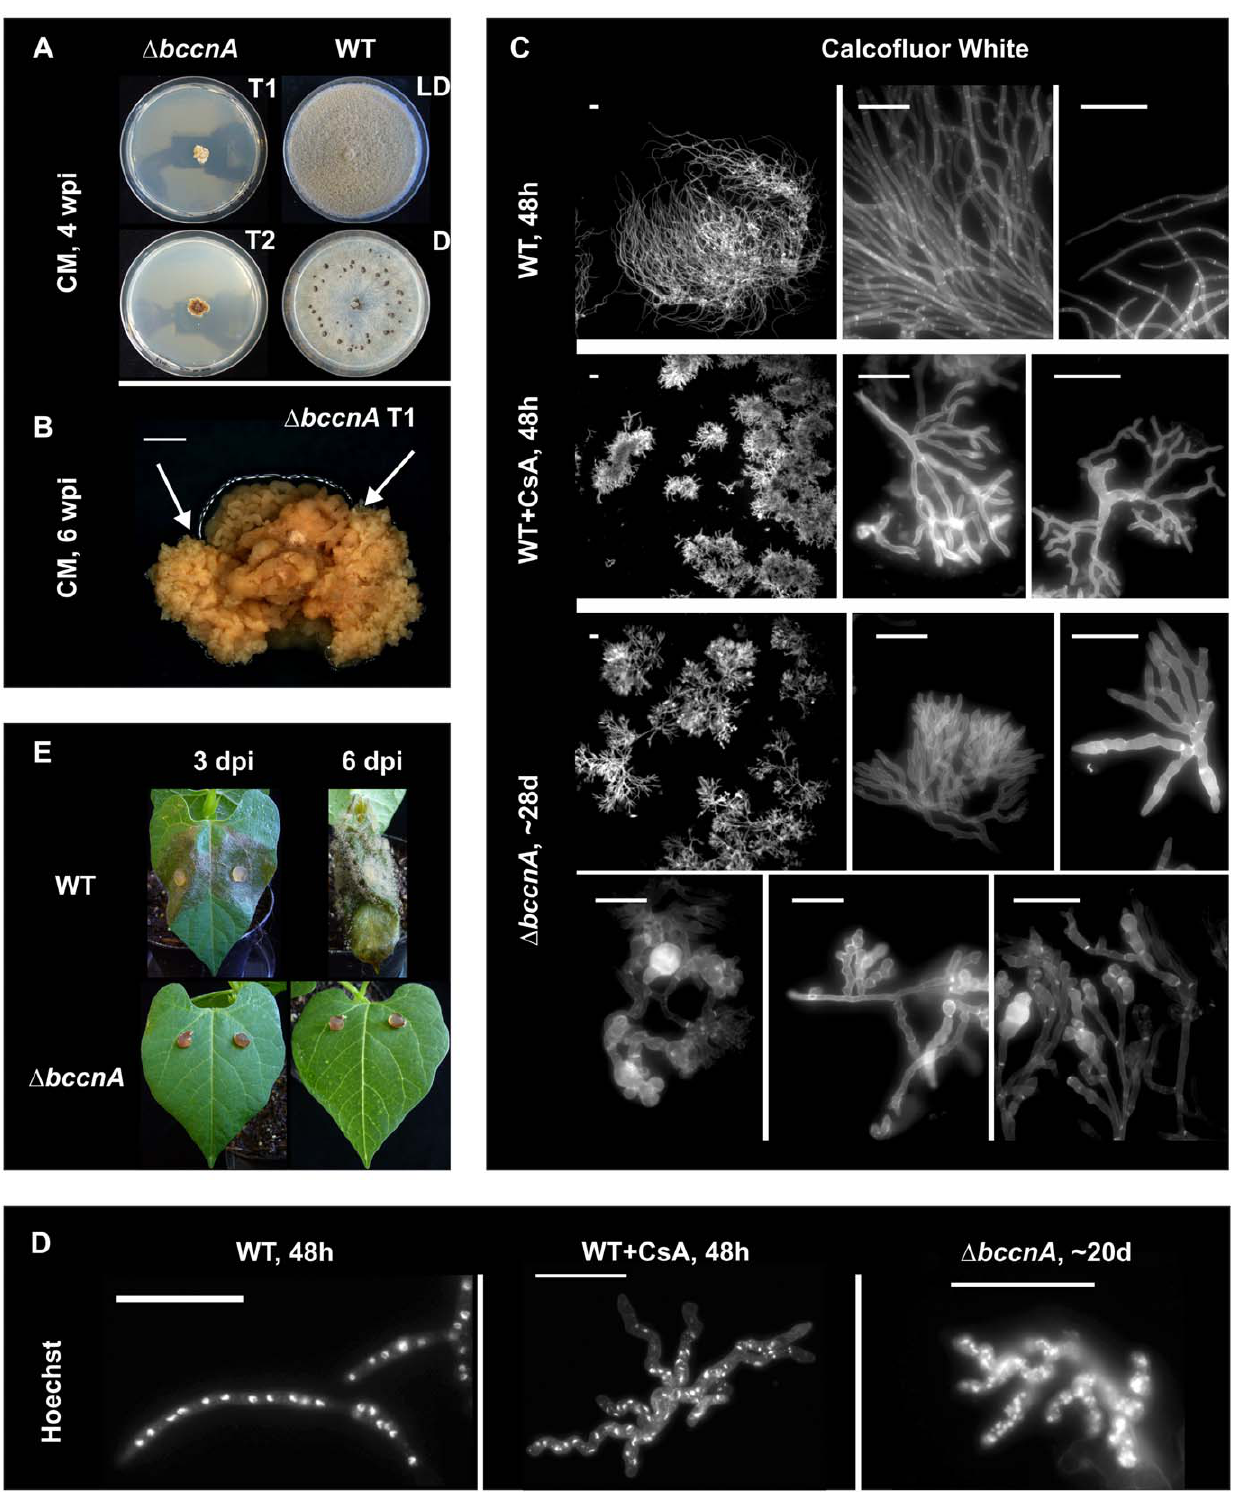
Figure 1. Phenotype of D bccnA mutants. A: Colony growth on CM medium after 4 weeks post inoculation (LD: 12 h rhythm light/dark, D: constant darkness), respectively. Two different primary D bccnA mutants T1 and T2 were tested in comparison to the B. cinerea wild-type B05.10. B: Growth of D bccnA mutant after 6 weeks on CM medium. Arrows indicate sector formation and different morphologies within one colony (scale bar 2 mm). C–D: Hyphal morphology and nuclei staining of B. cinerea strains with reduced calcineurin activities. Wild-type conidia (WT) were incubated for 48 h in liquid CM medium with and without 10 m g/ml of the calcineurin inhibitor cyclosporine A (CsA). D bccnA mycelia were incubated for 3 to 4 weeks in liquid CM medium. Cell walls and septa were stained with the fluorescent dye Calcofluor White. Scale bar: 20 m m (C). Nuclei were visualized using the fluorescent dye Hoechst 33342 (for details see Materials and Methods). Scale bar: 50 m m (D). Wild-type conidia (WT) were